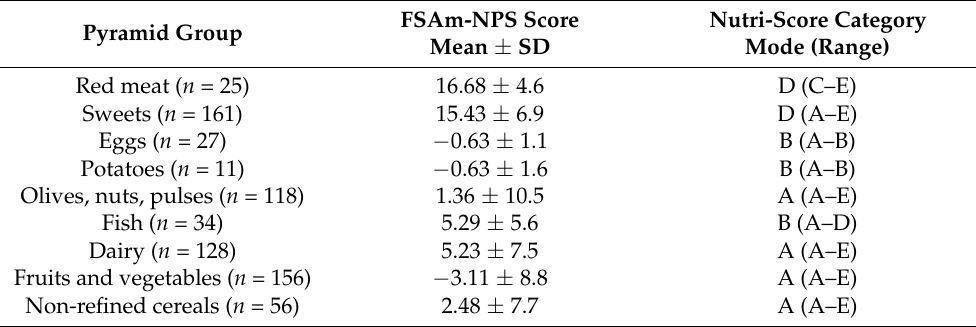
Table 2. FSAm-NPS Score and Nutri-Score category across the traditional Mediterranean diet tiers [27].